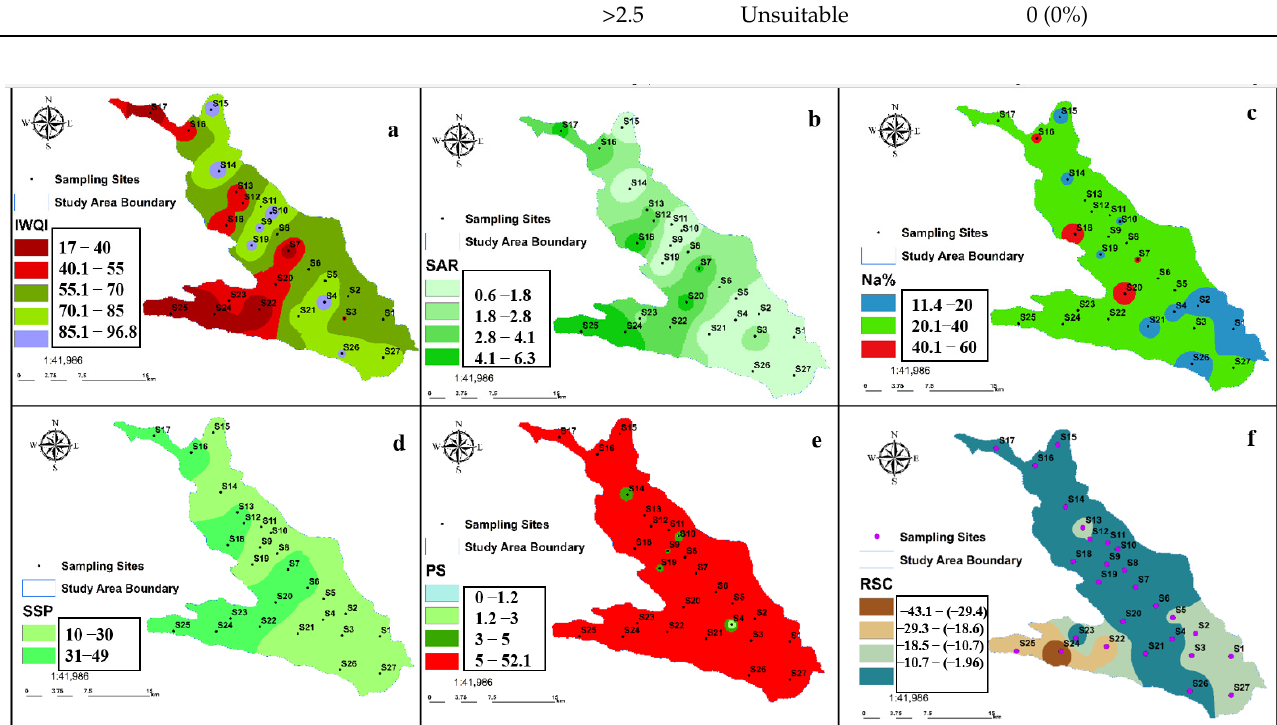
Figure 14. The spatial variation maps of the IWQIs for Al-Jawf plain: ( a ) IWQI, ( b ) SAR, ( c ) Na %,